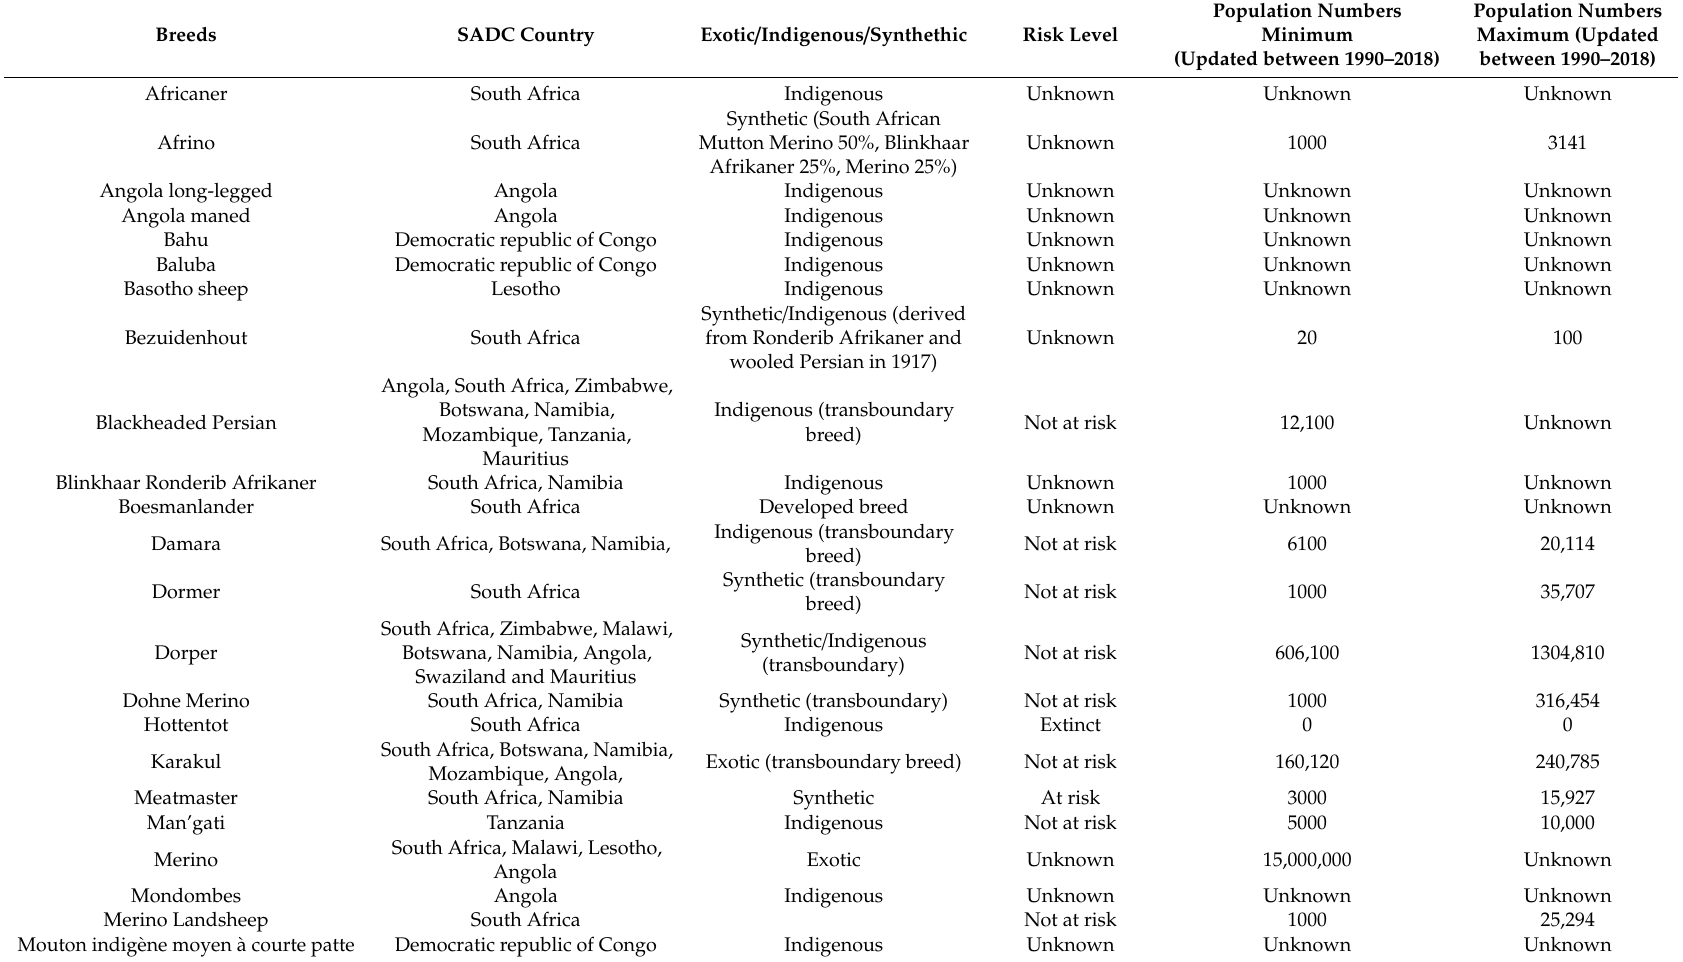
Table 1. List of indigenous sheep breeds present in the di ff erent Southern African Development Communities (SADC) countries and their estimated risk level. Adapted from the FAO-DAD-IS database